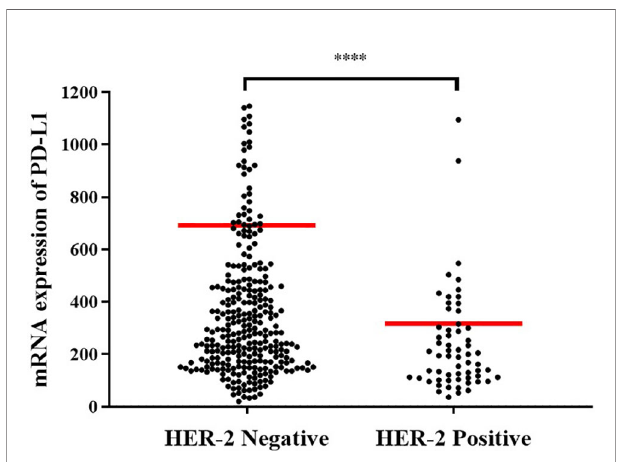
FIGURE 3 | Expression levels of PD-L1 mRNA in different HER-2 gene states. HER-2 amp represents HER-2 ampli fi cation; HER-2 non-amp indicates HER-2 non-ampli fi cation. ****P < 0.0001.